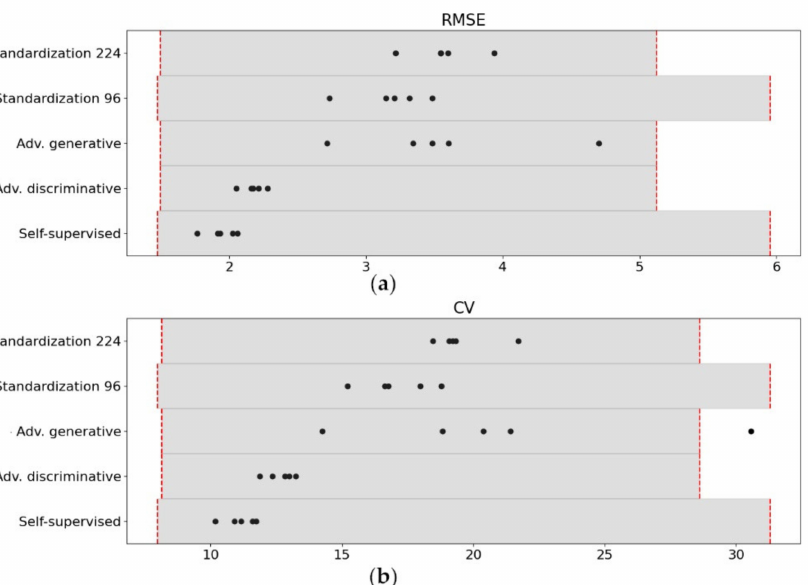
Figure 6. Visualization of the spread of the performance results obtained on the Icelandic data for the methods that are considered as domain adaptation. Each dot corresponds to one of the 5 trials. The red dashed lines delimiting the gray bars correspond to the higher (left) and lower (right) averaged performance bounds obtained with designated resolution (depending on the